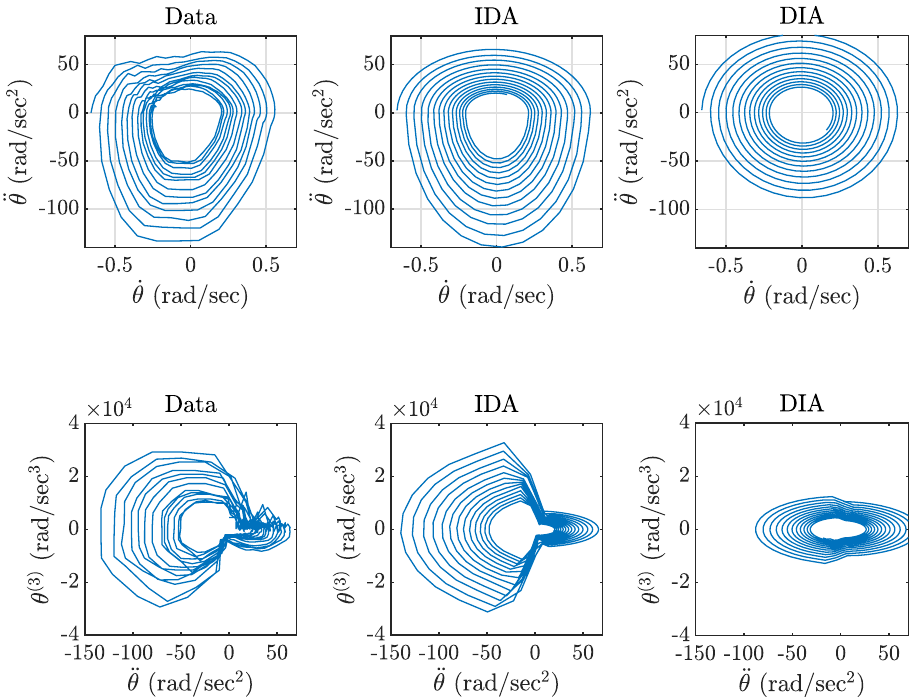
Figure 10. Phase space of nonlinear beam in two planes: ˙ θ -¨ θ and ¨ θ - θ ( 3 )